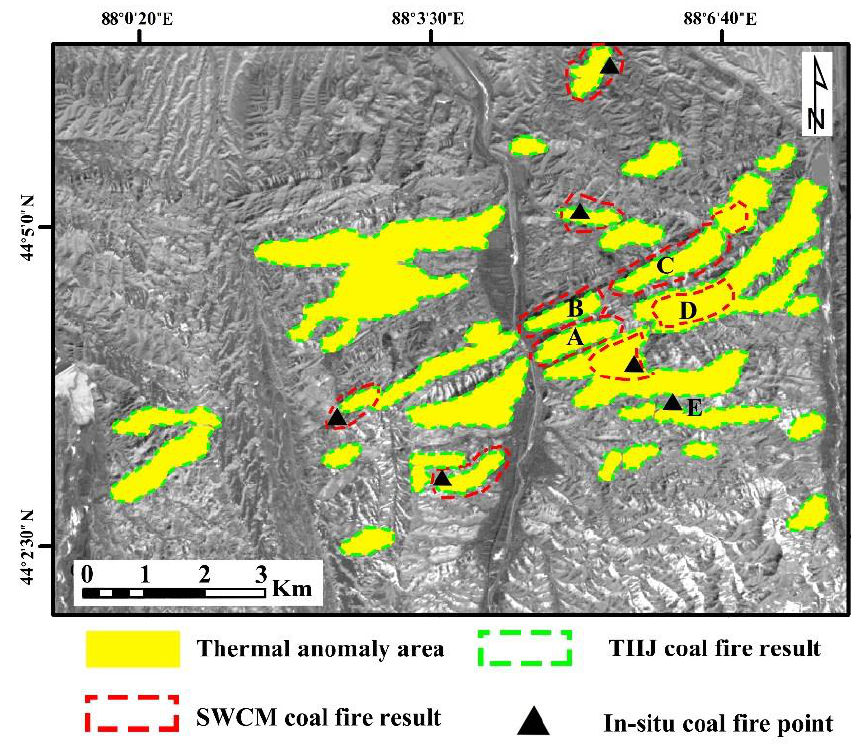
Figure 16. Fukang fire area identified by TIIJ and SWCM5.2. Reasons for commission errors and omission errors of coal fire areas.